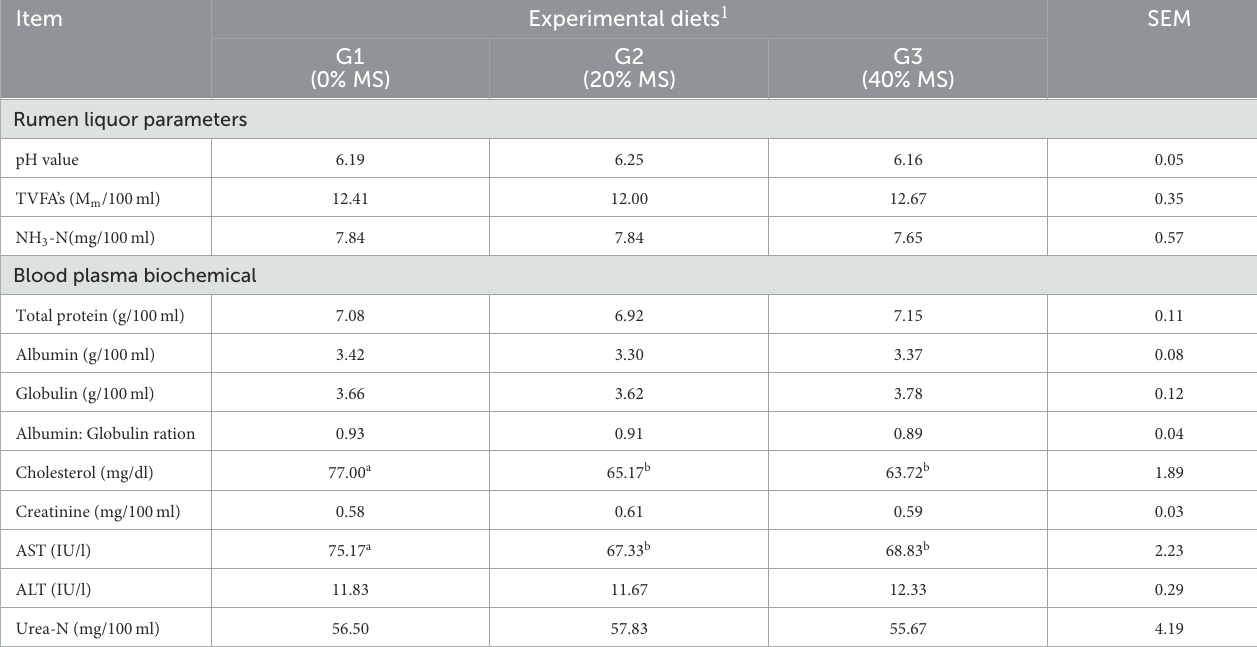
TABLE 7 Blood parameters of Damascus female goat fed different experimental